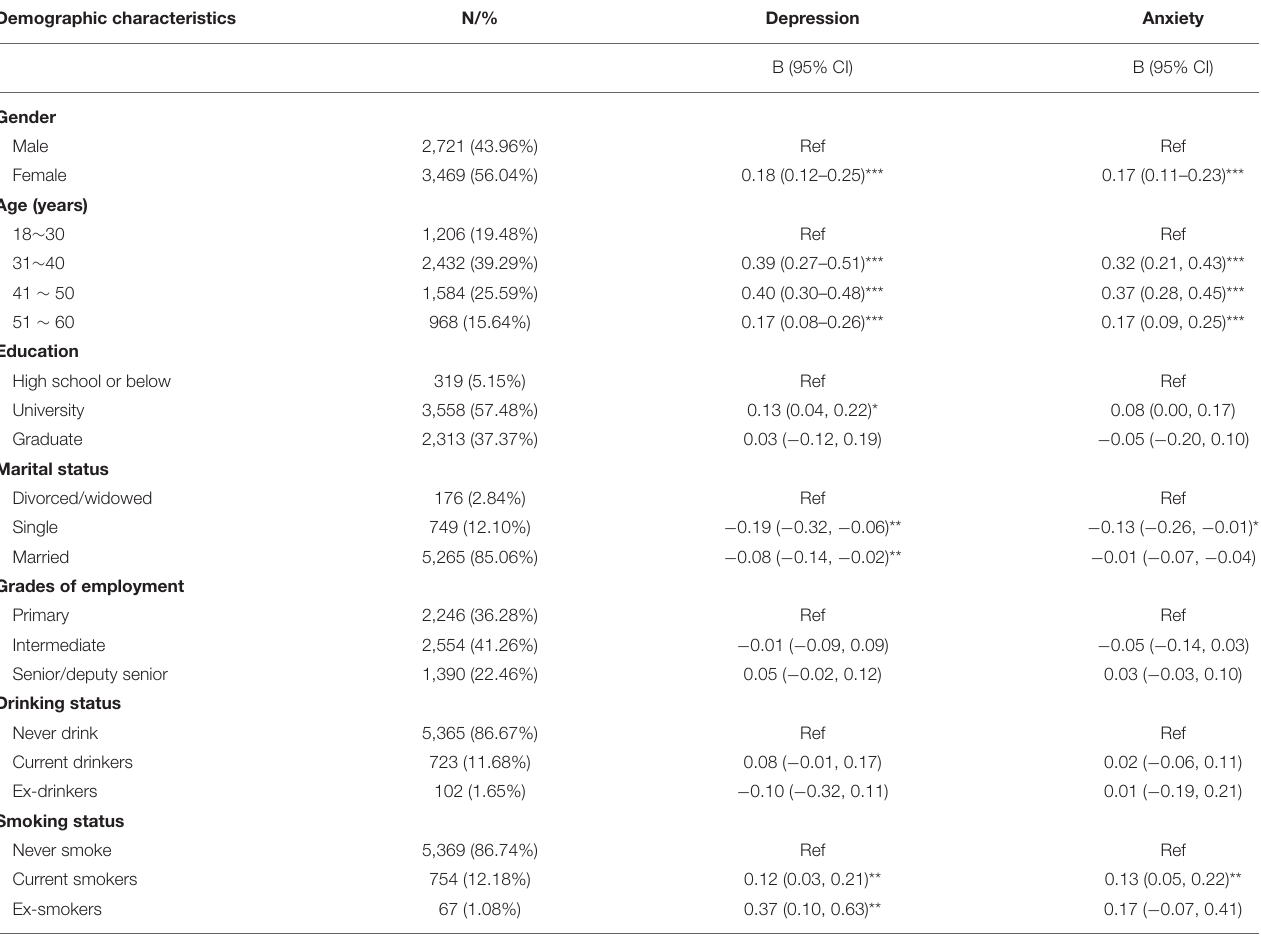
TABLE 1 | Descriptive and univariate regression analyses of background characteristics on mental health problems. Demographic